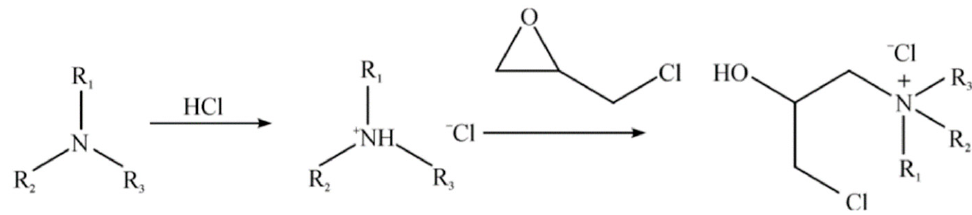
Figure 1. The reaction process for synthesizing the quaternary ammonium salt. The adsorbent was synthesized with quaternary ammonium cations and cellulose. At a ratio of 1:60, cotton balls were put into a bath of ultra-pure water and the quaternary ammonium salt solution was added at a concentration of 40 g · L − 1 . By heating the mixture to 75 ◦ C, the cotton balls came in full contact with the quaternary ammonium salt. The mixture was then cooled to 50 ◦ C, and sodium hydroxide was added at a concentration of 20 g · L − 1 for 30 min [22,24]. The reaction principle, based on Bao et al. [22], is shown in Figure 2. Finally, the cotton balls were removed, rinsed thoroughly with pure water for 5 min, and dried in a drying oven at 60 ◦ C to obtain cellulose modified with quaternary ammonium